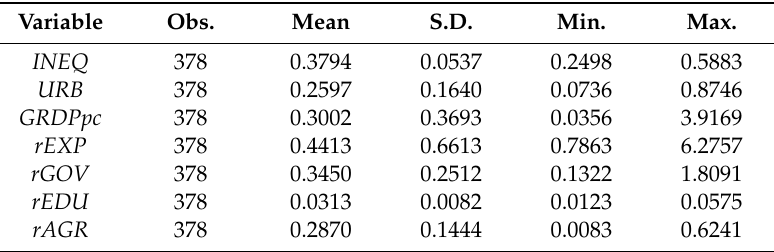
Table 2. Descriptive